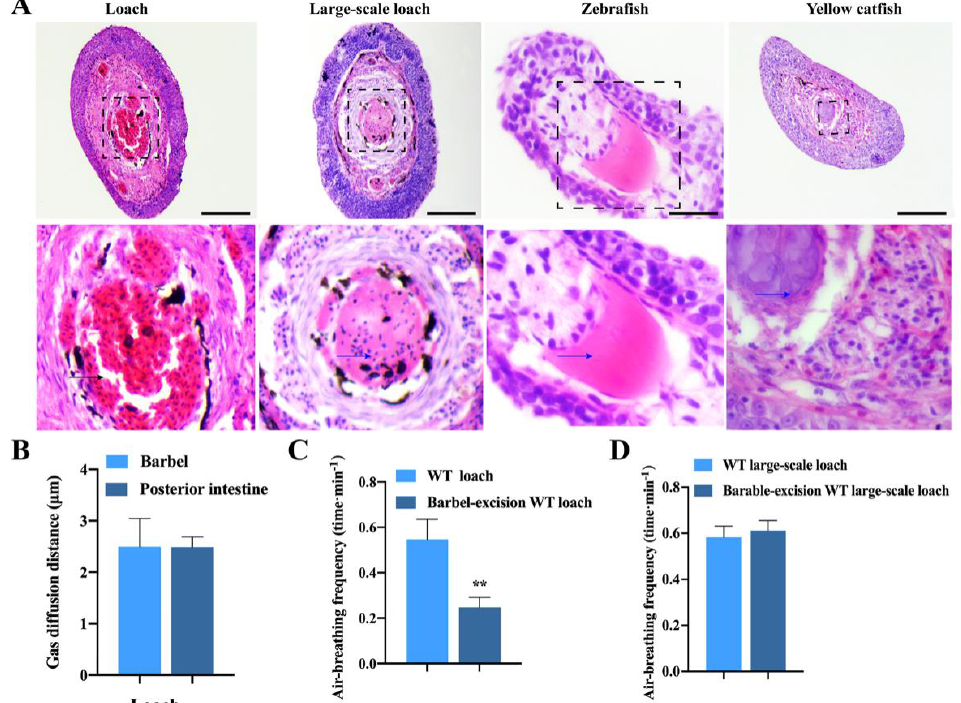
Figure 2. Comparisons of barbel histological structures, gas diffusion distances, and air-breathing frequency. ( A ) Comparison of histological structures of barbels among loach, large-scale loach, zebrafish, and yellow catfish. The visual fields in black dotted boxes are magnified below. The black arrow indicates erythrocytes, and the blue arrows indicate cartilage tissues. Scale bar = 100 μm. ( B ) Comparison of gas diffusion distance between the barbel and posterior intestine of loach. ( C ) Comparison of air-breathing frequency between WT and barbel-excised loach. ( D ) Comparison of air-breathing frequency between WT and barbel-excised large-scale loach. WT, wild-type. ** very significant difference ( p < 0.01).